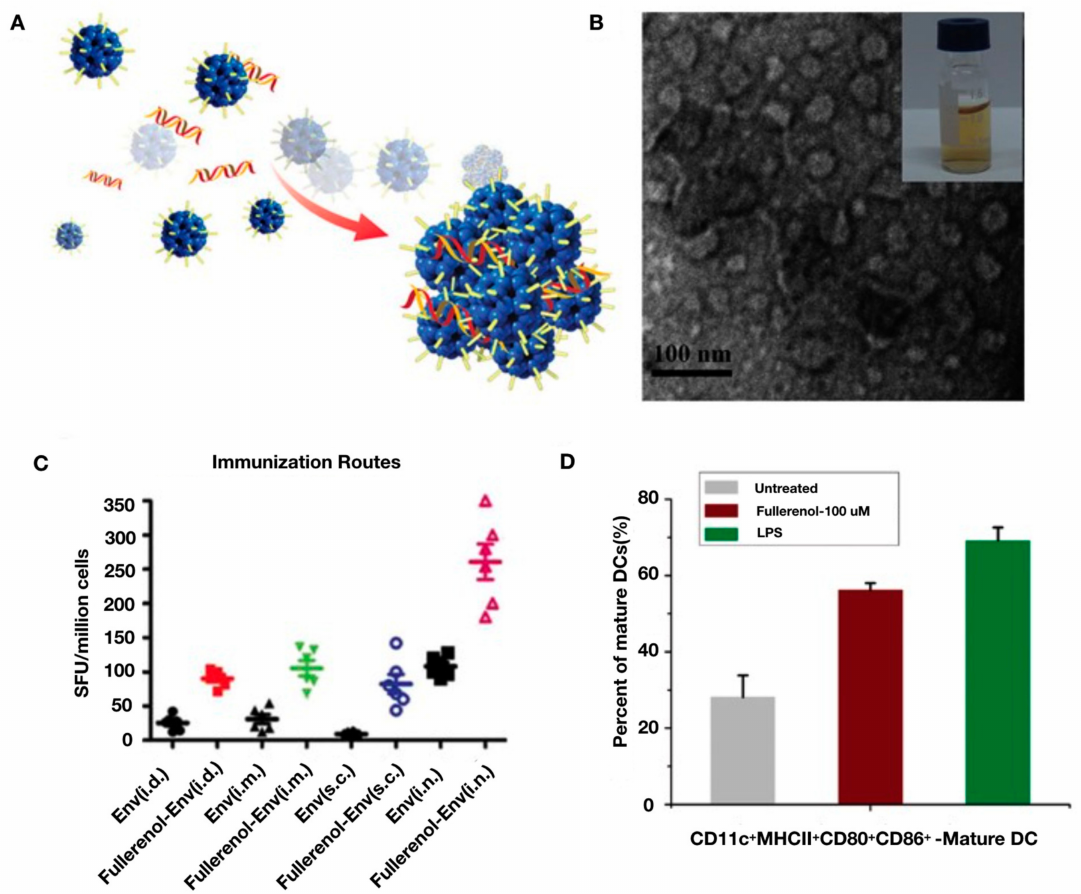
Figure 9. Fullerenol-based virus-like nanoparticles for DNA vaccine delivery. ( A ) Illustration of HIV-1-associated envelope protein, gp145 (Env), plasmid DNA encapsulated during the self-assembly of fullerenol into a virus-like particle. The blue speheres represent fullerenol molecules, the red and yellow wavy structures represent DNA strands, and the short linear sitcks represent hydroxyl